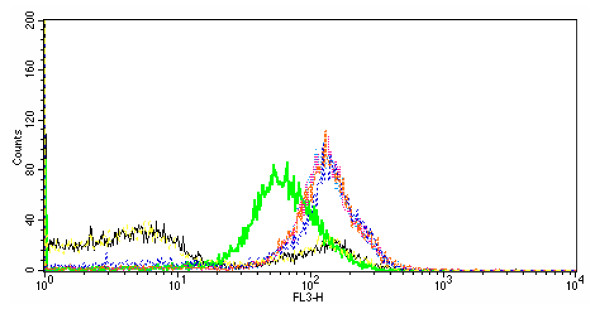
Influence of different fatty acids on PI fluorescence of B. fibrisolvens JW11 by flow cytometry. Black - live cells; green - heat-killed cells; pink - 50 μg ml-1 LA; turquoise - 50 μg ml-1 LNA; orange - 50 μg ml-1 CLA; blue - 50 μg ml-1 VA; yellow - 50 μg ml-1 SA.